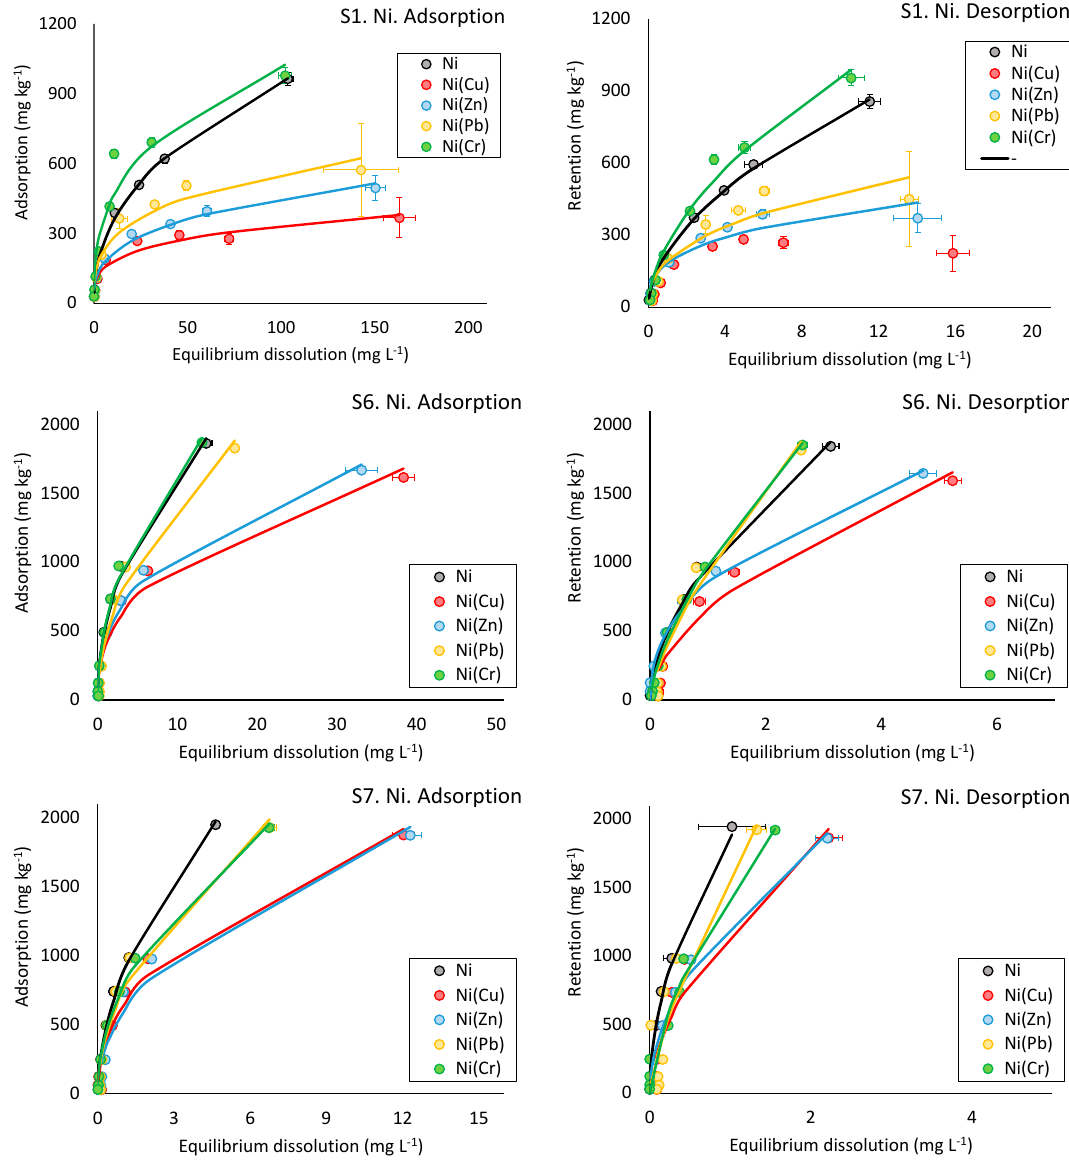
Figure 3. Competitive (coloured) and single (black) adsorption and desorption curves of Ni by soil S1, S6 and S7 samples.